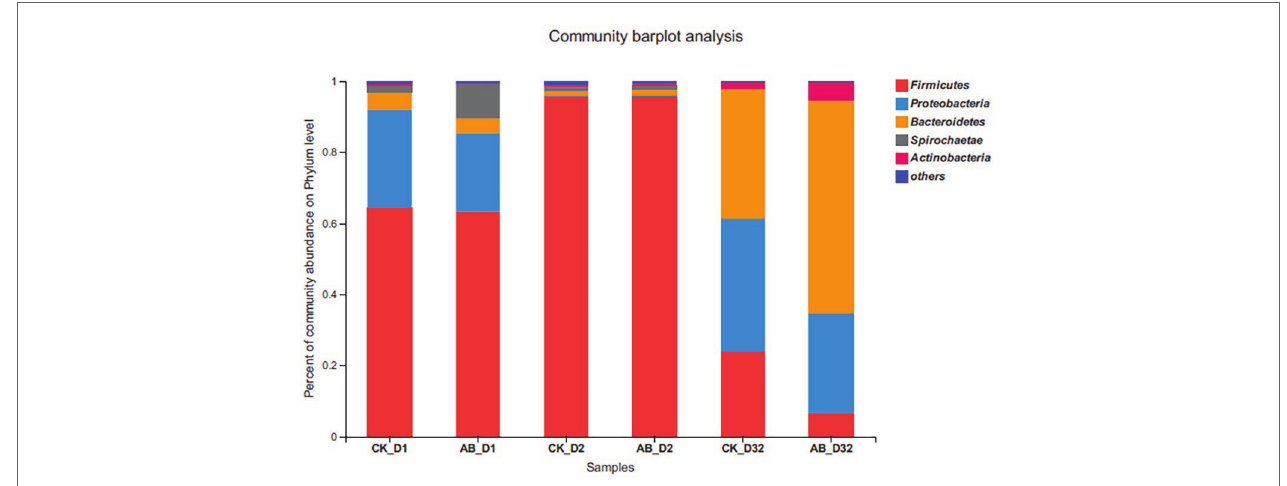
FIGURE 4 | Structure and abundance of flora at the phylum level. CK: the swine manure composting. AB: add 1% compound microbial agents in the swine manure composting. D1 represents the mesophilic phase, D2 represents the thermophilic phase, and D32 represents the maturation phase.